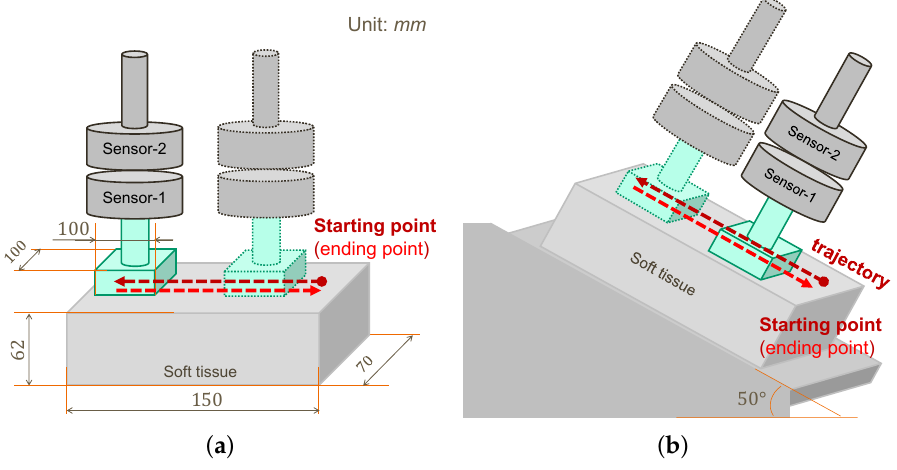
Figure 3. Two scenarios of soft tissue surface, i.e., horizontal and inclined slope. ( a ) Horizontal scenario. ( b ) Slope